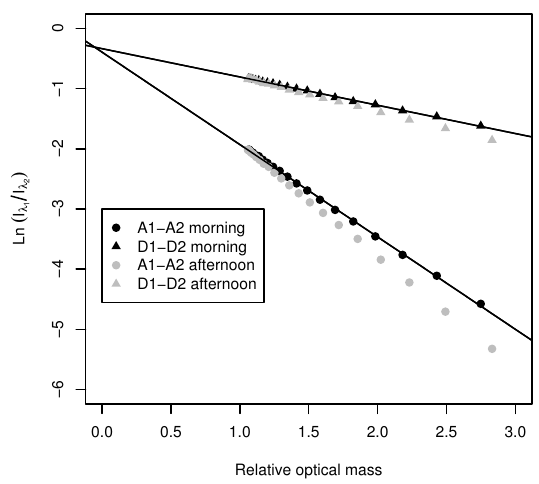
Fig. 1. Langley plots for the two pairs of wavelengths (A1–A2, D1– D2) corresponding to 2 July 2005. Morning values (time < 12) are shown in black, while afternoon values are displayed in grey. The two regression lines for the morning values have been added to the